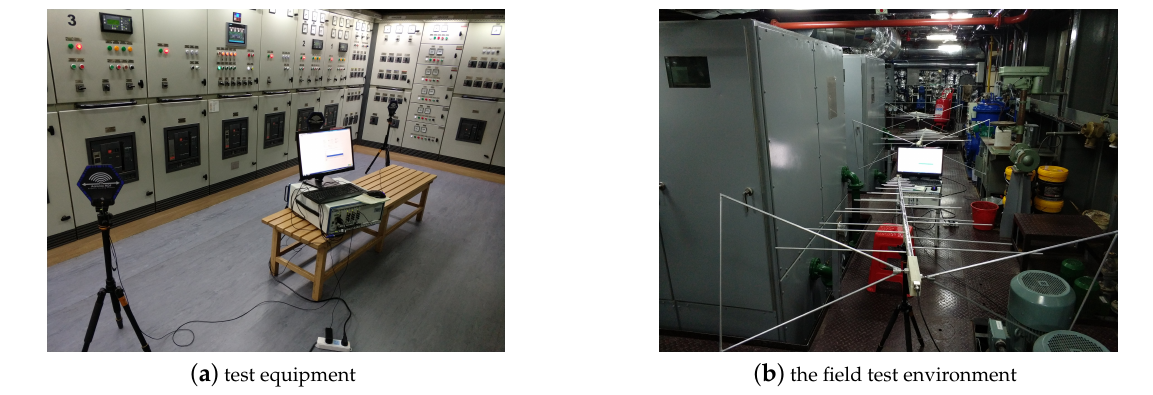
Figure 19. Field environmental test of generator set in ship engine room.